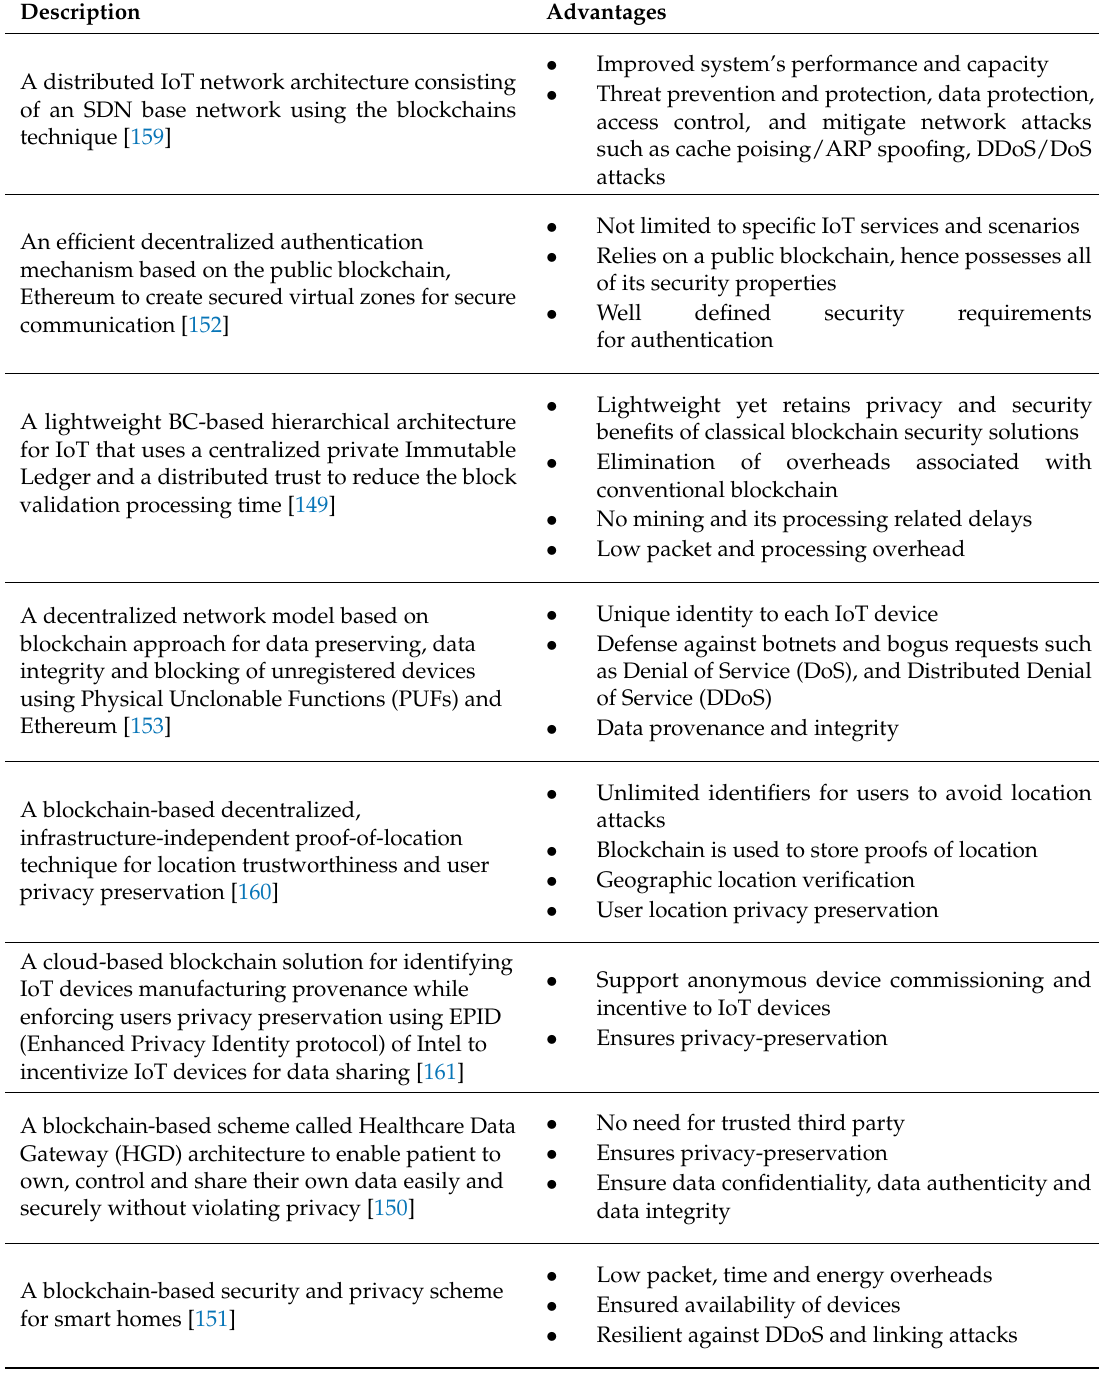
Table 6. Blockchain-based security solutions in IoT